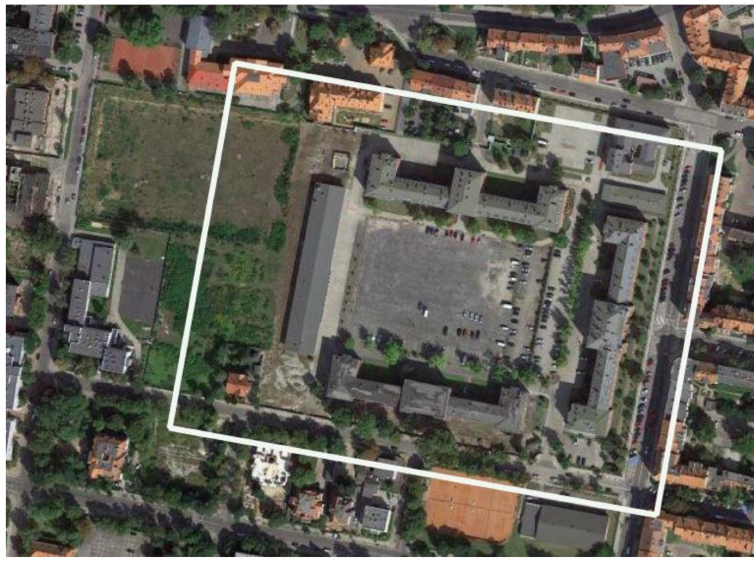
Figure 5. Localization of the site of Grenadier barracks (map source: